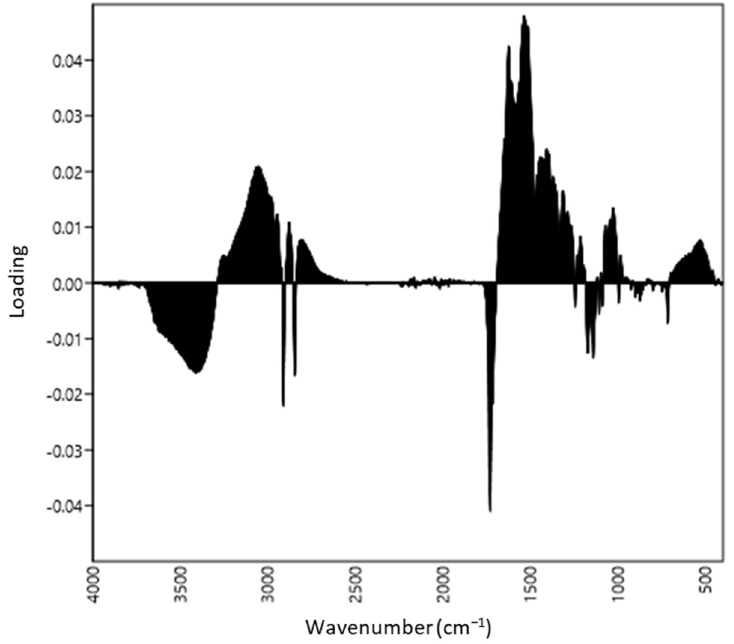
Figure 3. Loadings plots produced by PC 2 with peaks at 1408, 1545, 1626 and 1737 cm − 1 .